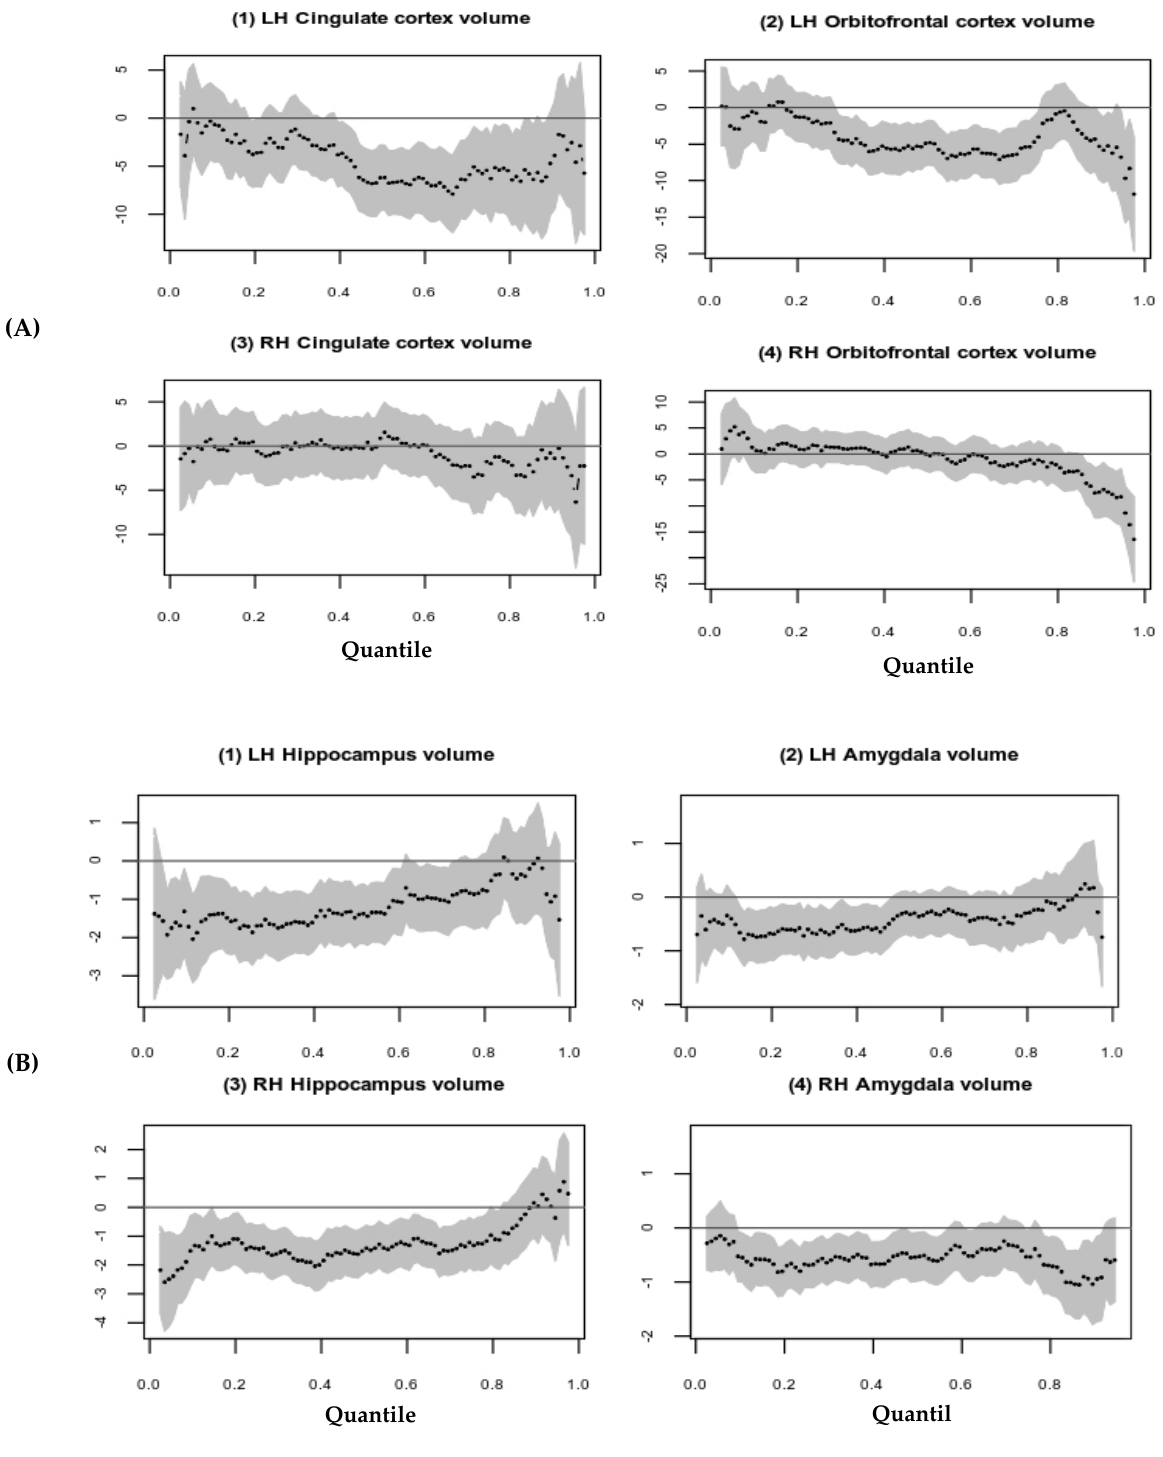
Figure 2. Association between parental externalizing behavior and limbic structures volume (mm 3 ) using Quantile regression plots; ( A ) Association between parental externalizing behavior ( y -axis) and cortical limbic structures ( x -axis); ( B ) Association between parental externalizing behavior ( y -axis) and subcortical limbic structures ( x